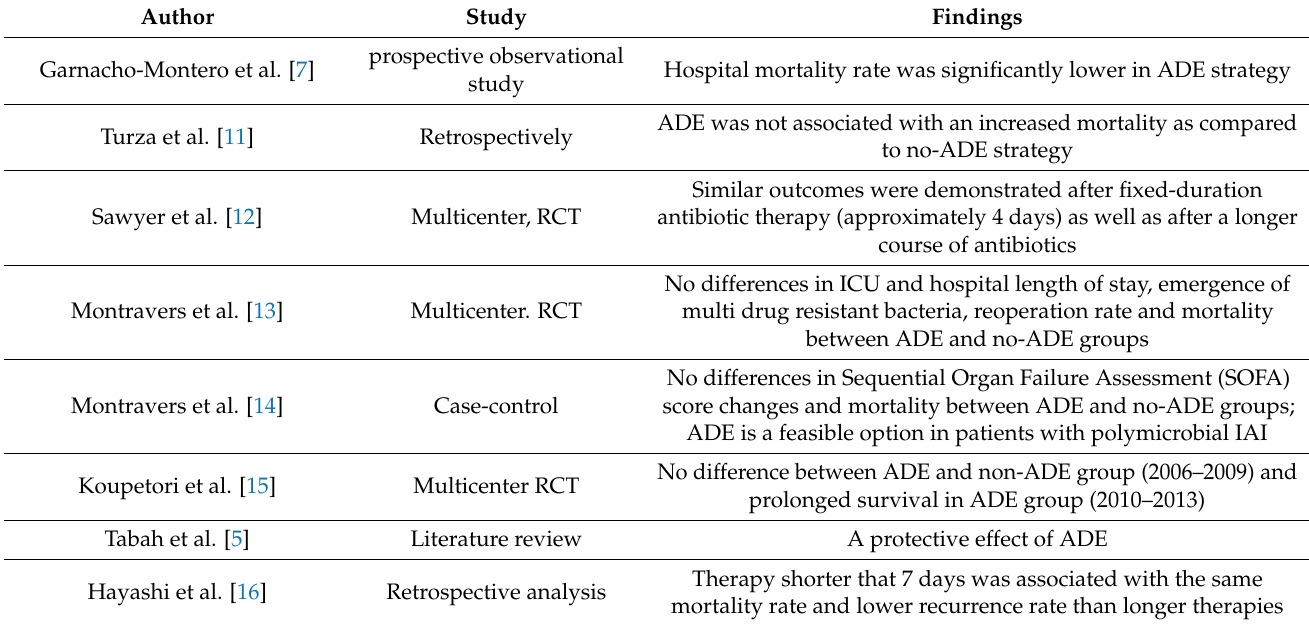
Table 2. Major studies available investigating ADE in